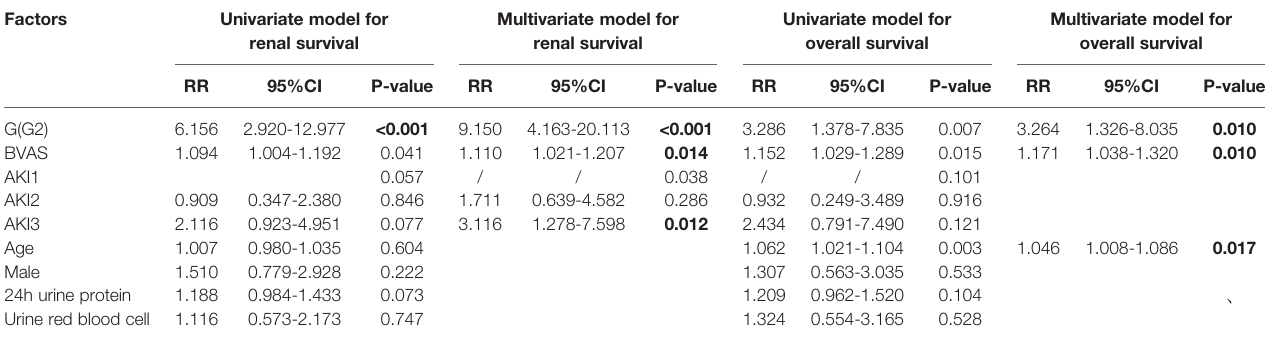
TABLE 4 | Cox model for long-term outcome.